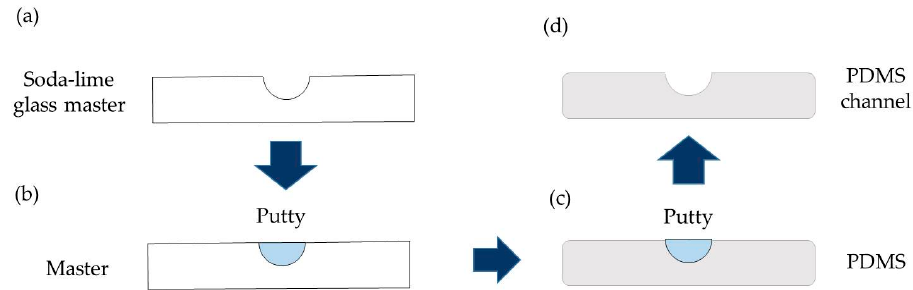
Figure 2. Scheme of the replication process. ( a ) Soda-lime glass master fabricated by laser techniques; ( b ) The putty is placed inside the channel to obtain the inverse structure of the master; ( c ) The putty mold is covered with PDMS and cured; ( d ) Finally, after peeling off the PDMS, the final channel is obtained.